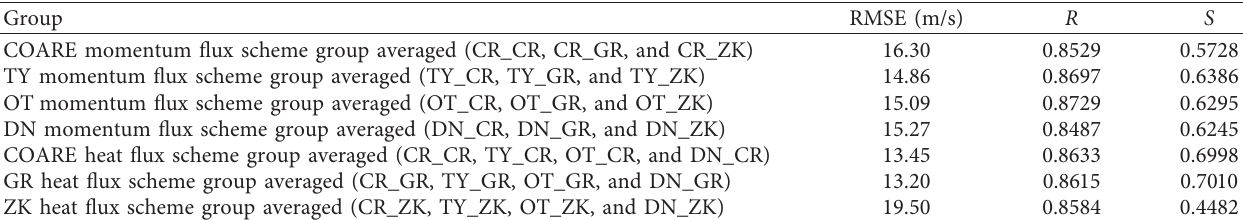
Table 6: Averaged root mean square error (RMSE), Pearson correlation coefficient ( R ), and model skill ( S ) for UMAX from different